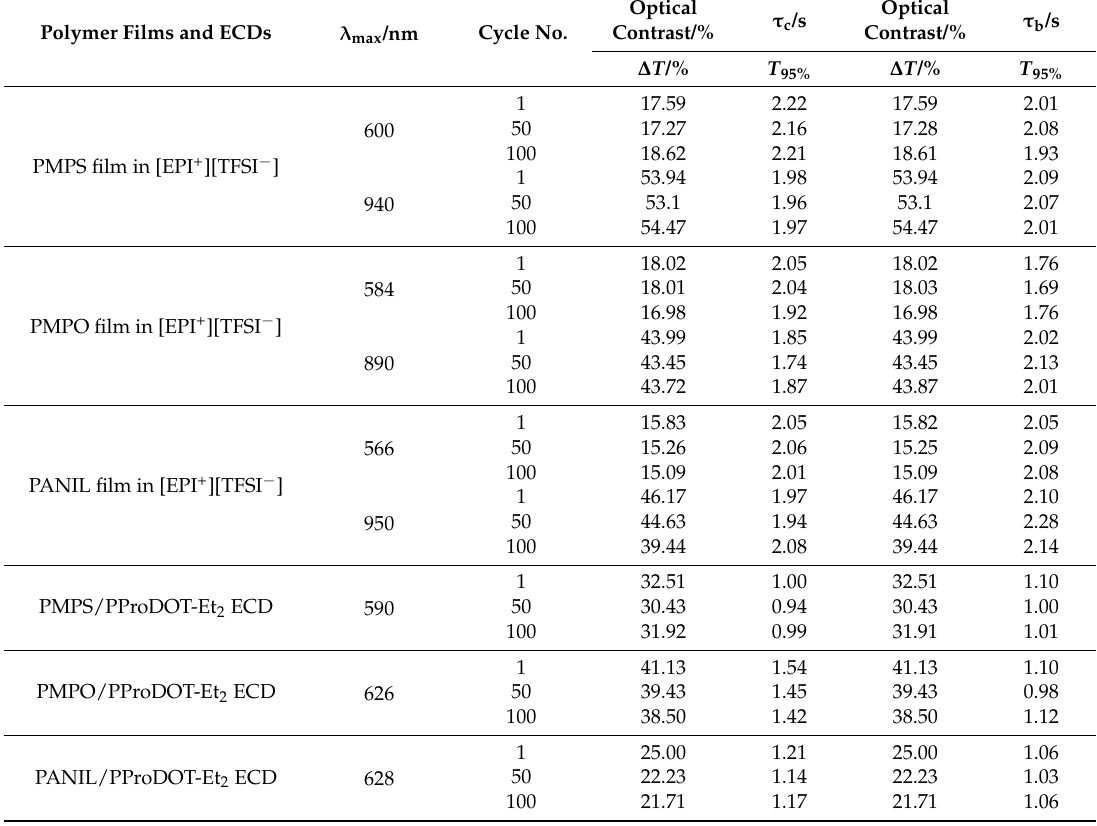
Table 3. Color-bleach kinetics of PMPS, PMPO, and PANIL films in [EPI + ][TFSI − ] and ECDs. Polymer Films and ECDs λ max /nm Cycle No.